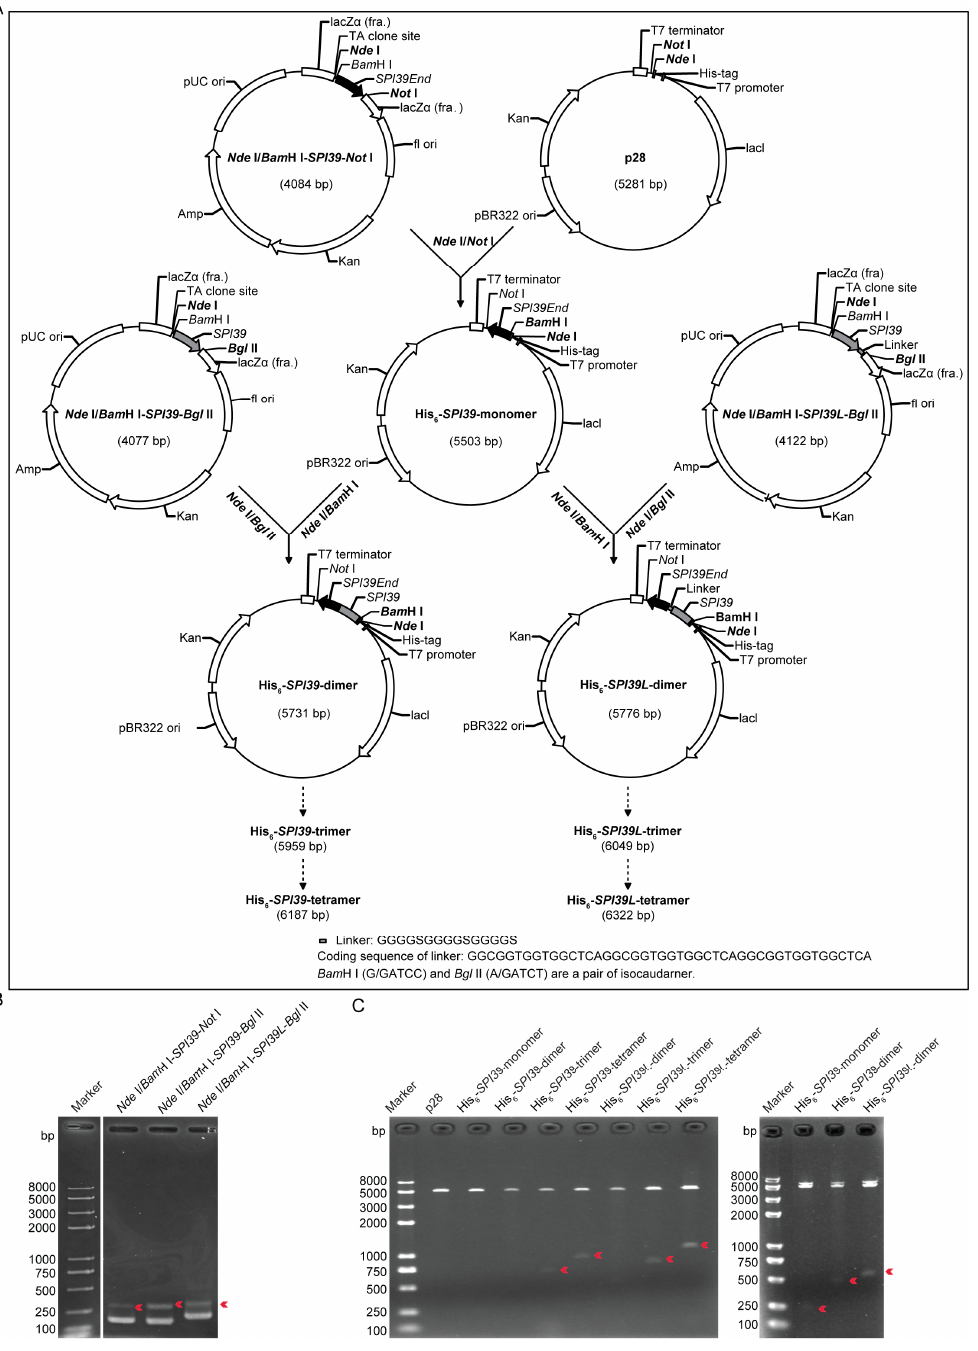
Figure 1. Design and construction of expression vector of BmSPI39 tandem multimers. ( A ) Schematic diagram of expression vector construction of BmSPI39 tandem multimers. Glycine-rich flexible linker was used to connect protein modules. “ SPI39 ” represents the coding sequence of BmSPI39 protein module, and “ SPI39L ” represents the coding sequence of BmSPI39 protein module connected by flexible linker. The amino acid sequence of linker is “GGGGSGGGGSGGGGS”. The coding sequence of linker is “GGCGGTGGTGGCTCAGGCGGTGGTGGCTCAGGCGGTGGTGGCTCA”. Bam H I (G/GATCC) and Bgl II (A/GATCT) are a pair of isocaudarners. ( B ) Agarose gel electrophoresis detection of PCR